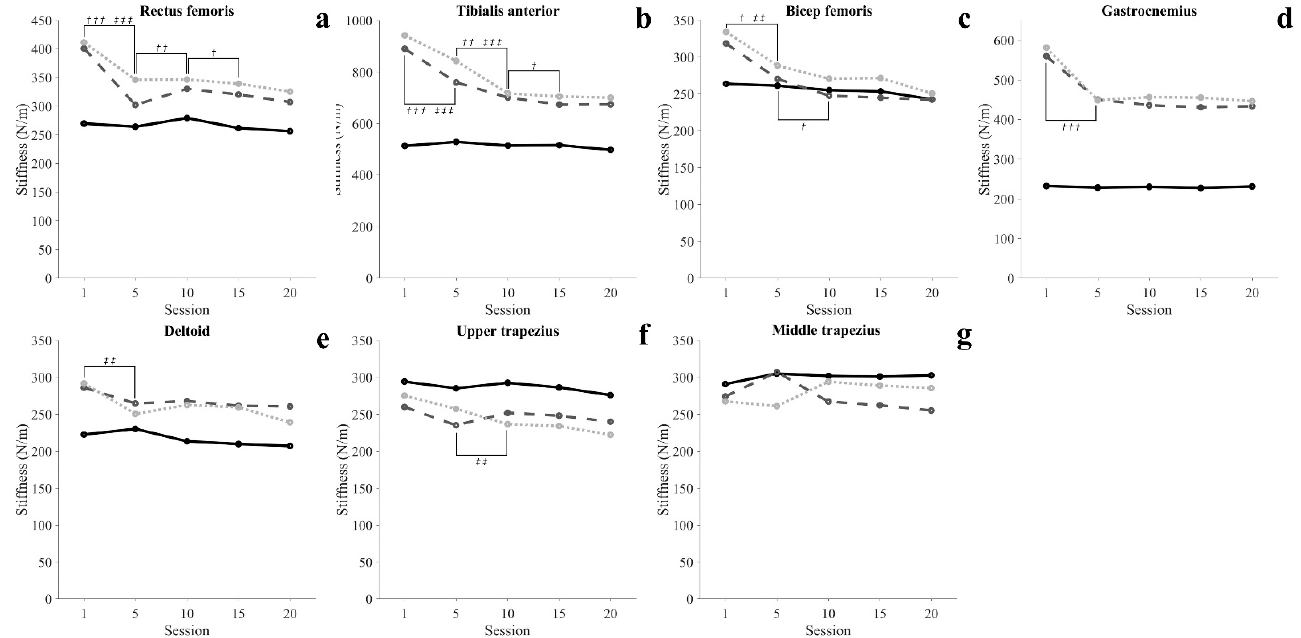
Figure 5. Time-series graphs of significant difference periods for muscle stiffness (sitting position: solid line; standing position: dashed line; wide standing position: dotted line). † Significant differences in a standing position, † = p < 0.05, †† = p < 0.01, ††† = p < 0.001. ‡ Significant differences in a wide standing position, ‡‡ = p < 0.01, ‡‡‡ = p < 0.001.